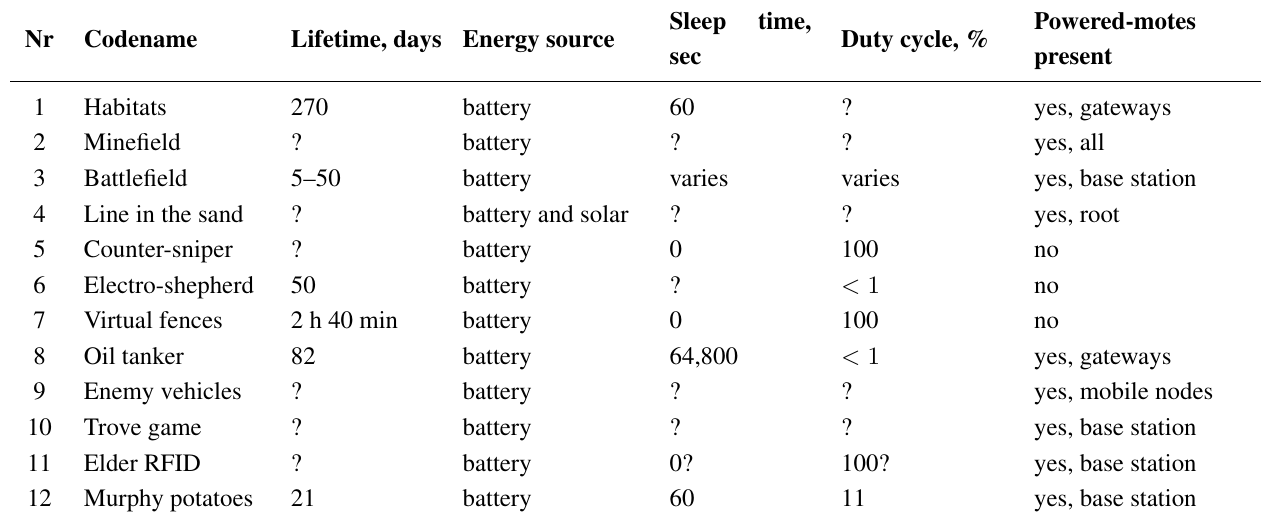
Table 4. Deployments: lifetime and